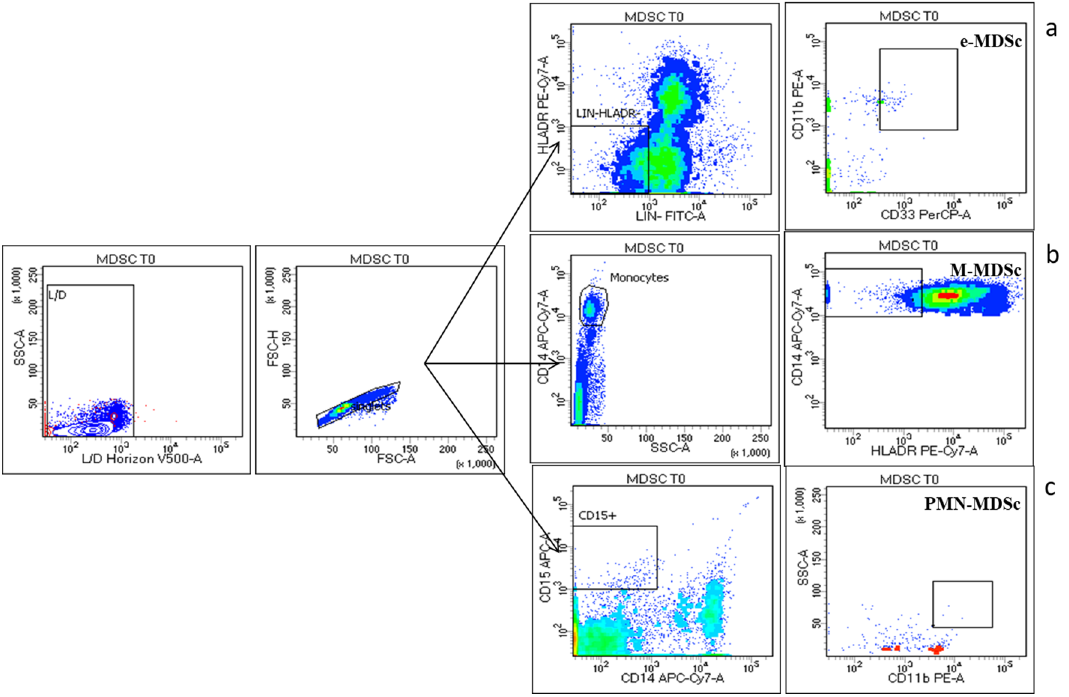
Figure 6. MDSC Cytometry gating strategy: three major MDSC subsets have been identified: The early MDSC (e-MDSC) was identified with surface expression of LIN-HLADR-/lowCD11b+CD33+ ( a ) myeloid MDSC (M-MDSC) as CD14+HLADRlow ( b ) and polymorphonuclear MDSC (PMN-MDSC) as CD15+CD11b+ SSCAhigh ( c ) gated in Live (Live/Dead Horizon V450 negative cells) and singlet cells.